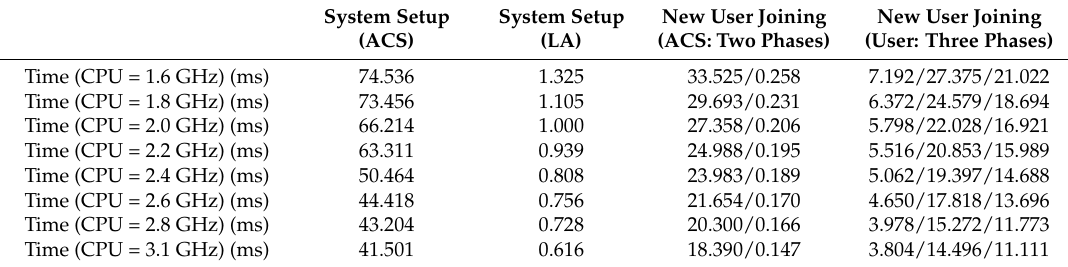
Table 7. Running time for some phases of our privacy-preserving framework.